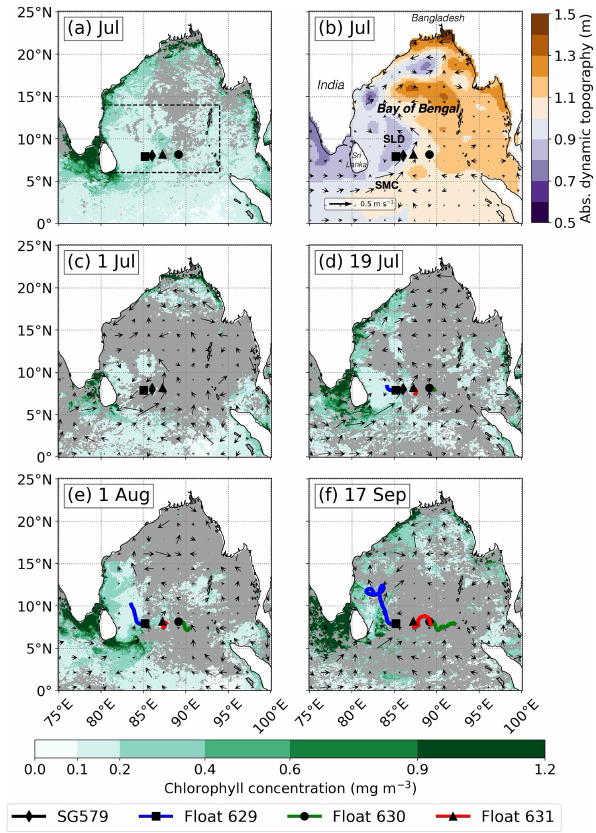
Figure 1. (a) Satellite composite of July 2016 average 4km chloro- phyll a concentration (mgm − 3 ) obtained from ESA OC-CCI ver- sion 3.1. The dashed black box shows the outline of Fig. 5a. (b) Ab- solute dynamic topography (m) of horizontal resolution (0 . 25 ◦ × 0 . 25 ◦ ) overlaid with surface geostrophic velocity (ms − 1 ) from AVISO for July 2016. (c–f) Satellite composite of 8-daily averaged 4km chlorophyll a concentration and surface geostrophic velocities for 1–8, 19–27 July, 1–8 August, and 17–25 September. Deploy- ment locations and trajectories of glider SG579 (diamond marker; black line), float 629 (square marker; blue line), float 630 (circle marker; green line), and float 631 (triangle marker; red line) are overlaid. Missing data are shaded